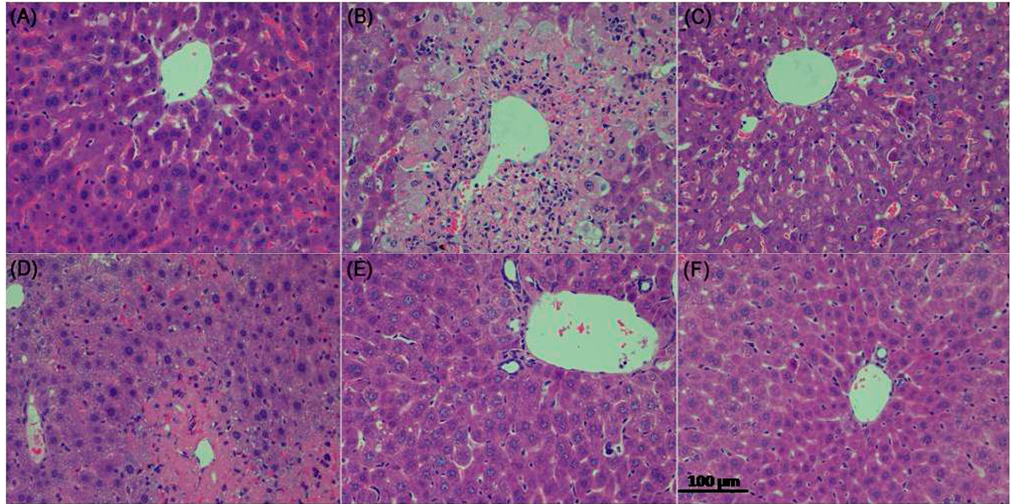
Figure 7. Histological analysis of the liver tissue of mice (HE staining 200×). ( A ) Control group; ( B ) APAP group; ( C ) Bifendate group; ( D ) ZJF-L group; ( E ) ZJF-M group and ( F ) ZJF-H group.